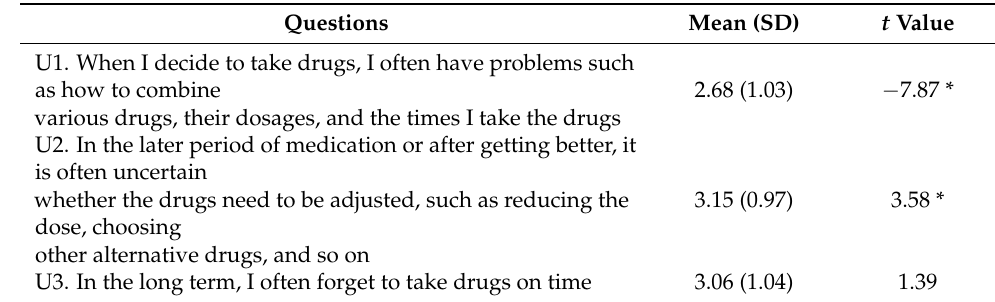
Table 3. Possibly problematic situations concerning the drug use practice.